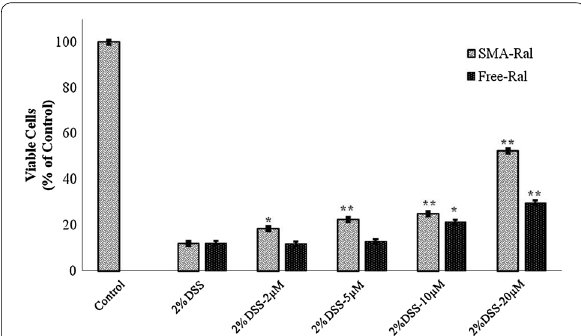
Fig. 3 Average CaCo2 cell number following 72 h of free and SMA Ral treatments. All data are expressed as mean SD. * denotes ± p 0.05 and ** denotes p 0.001 as determined by t test and in ≤ ≤ relative to the 2% DSS treated